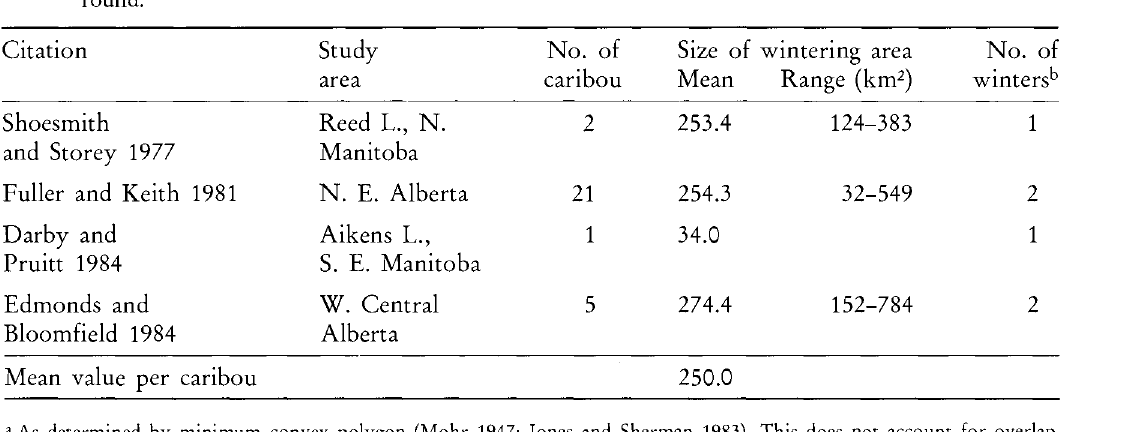
Table 1. Size of individual wintering areas 3 for radio-collared woodland caribou that occupy boreal forest year-